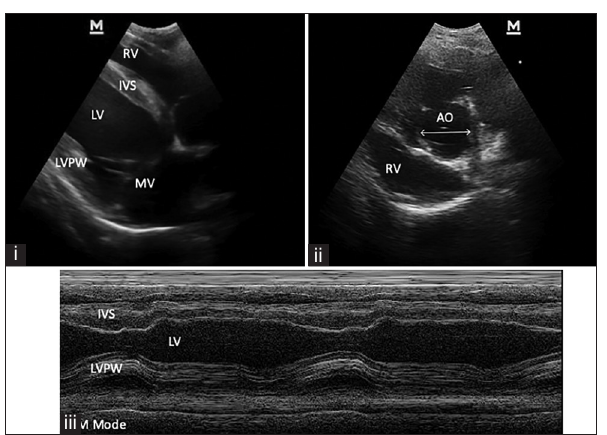
Figure-2: Echocardiographic of a longitudinal image of the heart (i), (ii) and motion mode (M mode) image of the left ventricle (iii); RV=Right ventricle, LV=Left ventricle, IVS=Interventricular septum, LVPW=Left ventricular proximal wall, MV=Mitral valve, and AO=Aorta.